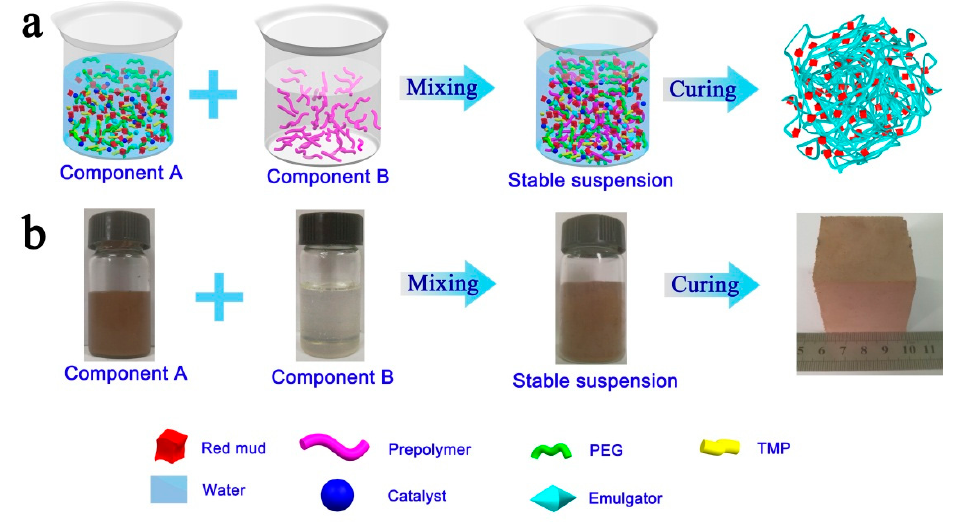
Figure 1. ( a ) Schematic illustration of the fabrication process of polyurethane/red mud composite (PRC). ( b ) Digital photographs of component A, component B, stable suspension, and cured PRC.